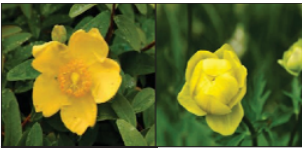
Figure 22: Globe-flower (right) is often classified as Rose of Sharon (left) (Source: Miller, 2014).